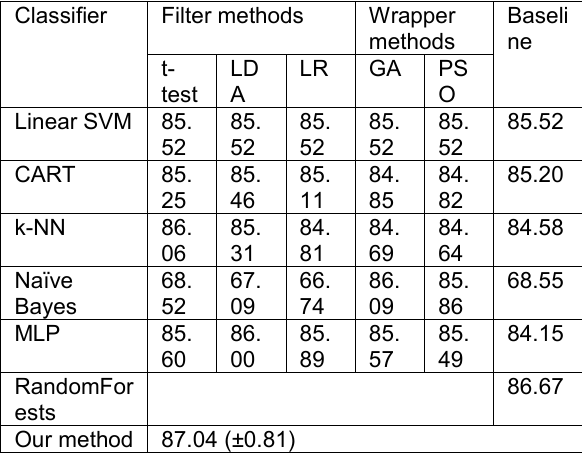
Table 1. Compare performances of different classifiers over the Australian credit